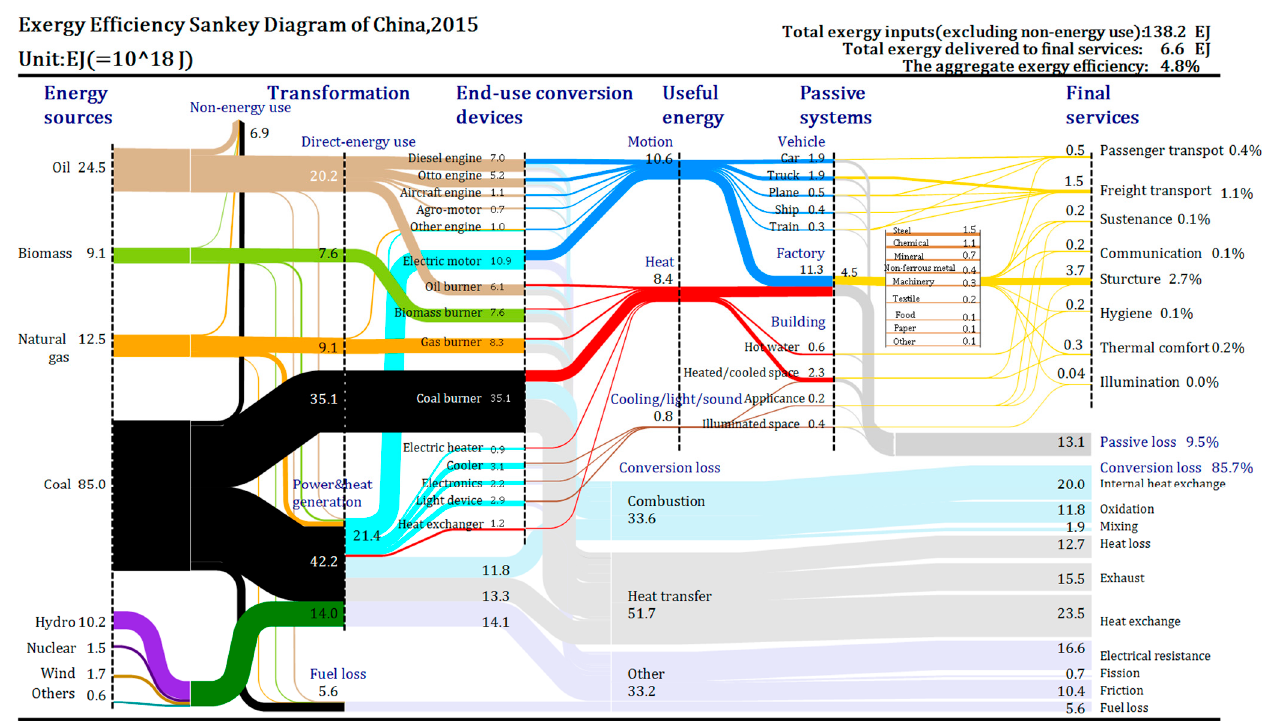
Figure 6. Exergy efficiency Sankey diagram from the energy source to final service of China in 2010.